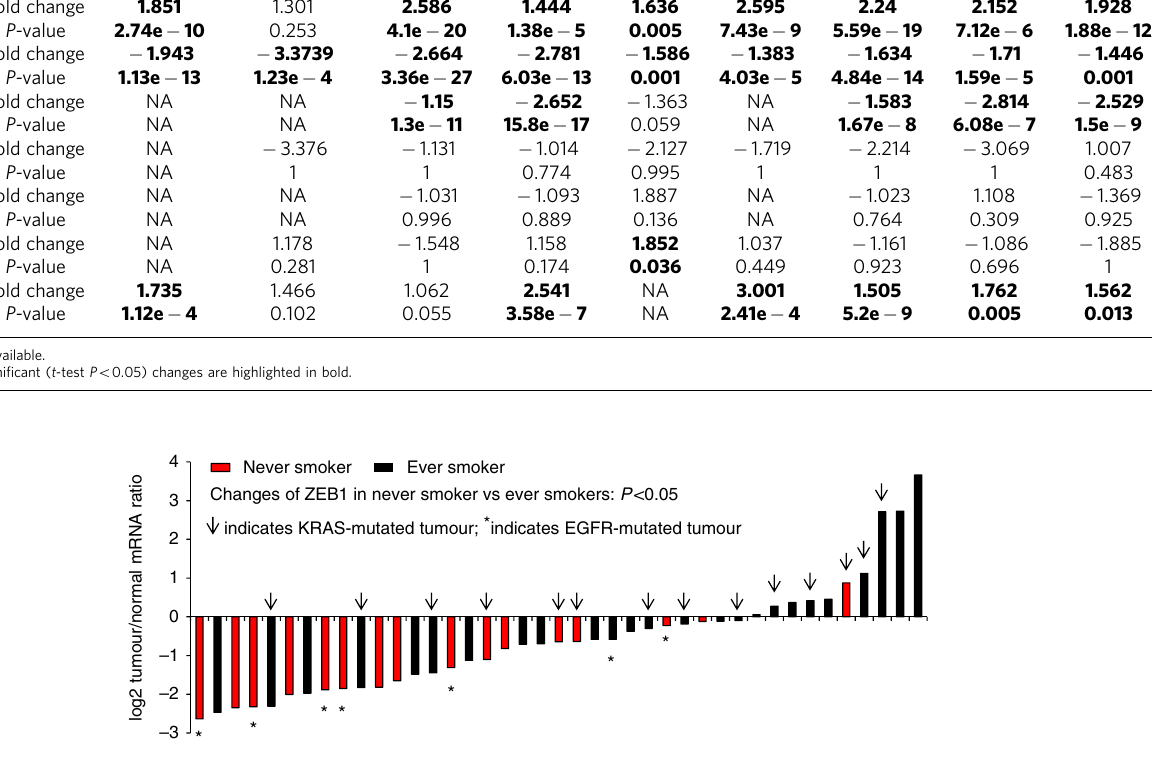
Table 1 | Lung adenocarcinoma/normal lung fold changes of EMT-related genes in the Oncomine data sets. Genes Data